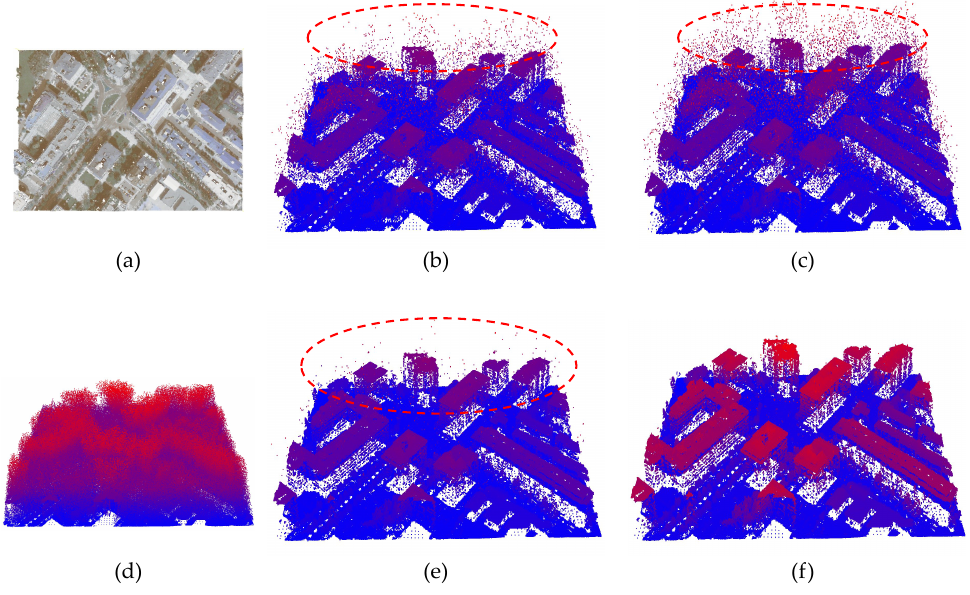
Figure 10. Analysis of single-scale and multiscale denoising results; ( a ) overview of the urban area; ( b ) three-dimensional view after denoising in the 5 m neighborhood; ( c ) three-dimensional view after denoising in the 10 m neighborhood; ( d ) raw SPL point cloud with noise; ( e ) three-dimensional view after denoising in the 5 m and 10 m neighborhoods; ( f ) three-dimensional view after denoising in the 5 m, 10 m, and 15 m